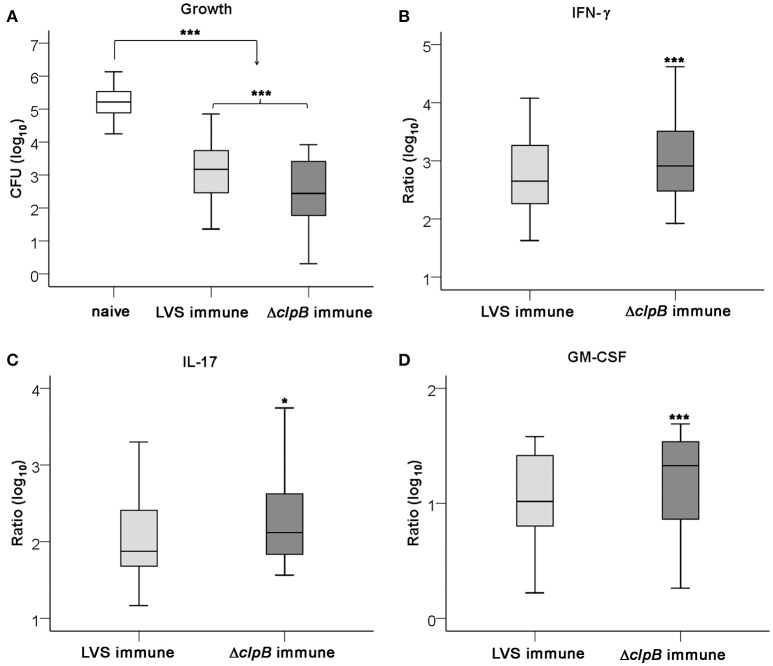
Growth of F. tularensis LVS and cytokine accumulation in the co-culture assay. Growth of LVS in cultures with naïve (white boxes), LVS-immune (light gray boxes) or ΔclpB-immune (dark gray boxes) splenocytes was determined after 72 h (A) and the accumulated levels of IFN-γ (B), IL-17 (C), and GM-CSF (D) in these cultures. Results shown represent data from 16 experiments in graph A and 11 experiments in graphs (B–D). Growth was calculated as the log10 CFU of cultures at 72 h subtracted with the log10 CFU of cultures at 0 h [median and IQ one and three 2.3 (2.1, 3.2)]. In graphs (B–D), the values are expressed as log10 fold-regulation of the indicated cytokine in relation to the concentration in cultures with naïve splenocytes. *P < 0.05, ***P < 0.001 according to Wilcoxon's signed rank test. In graphs (B–D), the significances indicate the pair-wise comparisons between LVS- and ΔclpB-immune data for each cytokine and in graph (A) for the indicated pair-wise comparisons.